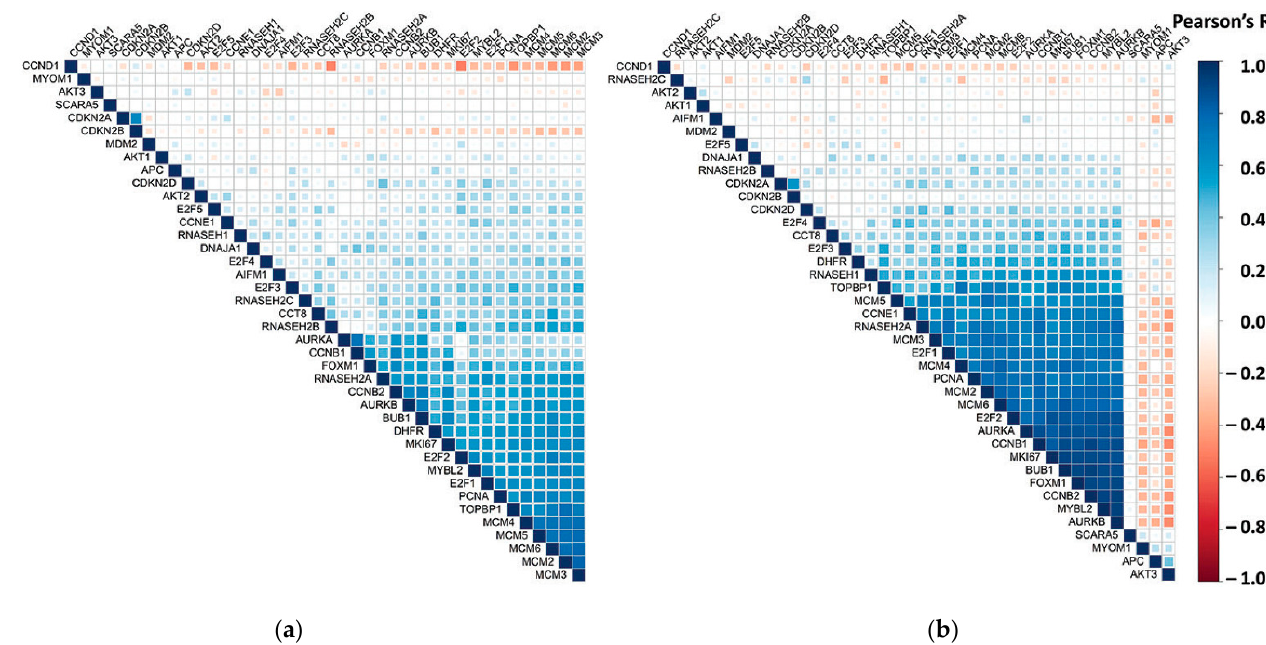
Figure 5. RNAESH2A correlation with 39 other genes previously listed in CCLE and TCGA Pan Cancer datasets: ( a ) correlation coefficient plot generated from RNA-Seq expression levels in 1019 cancer cell lines from CCLE database measured in RPKM (log2 (value + 1)); ( b ) correlation coefficient plot generated from RNA-Seq expression levels in 10,071 cancer tissue samples from the Cancer Genome Atlas (TCGA) Pan Cancer studies measured in RSEM (Bach normalized from Illumina HiSeq_RNASeqV2(log2 (value + 1)). The proportion of shaded area in each cell corresponds to the Pearson’s R.